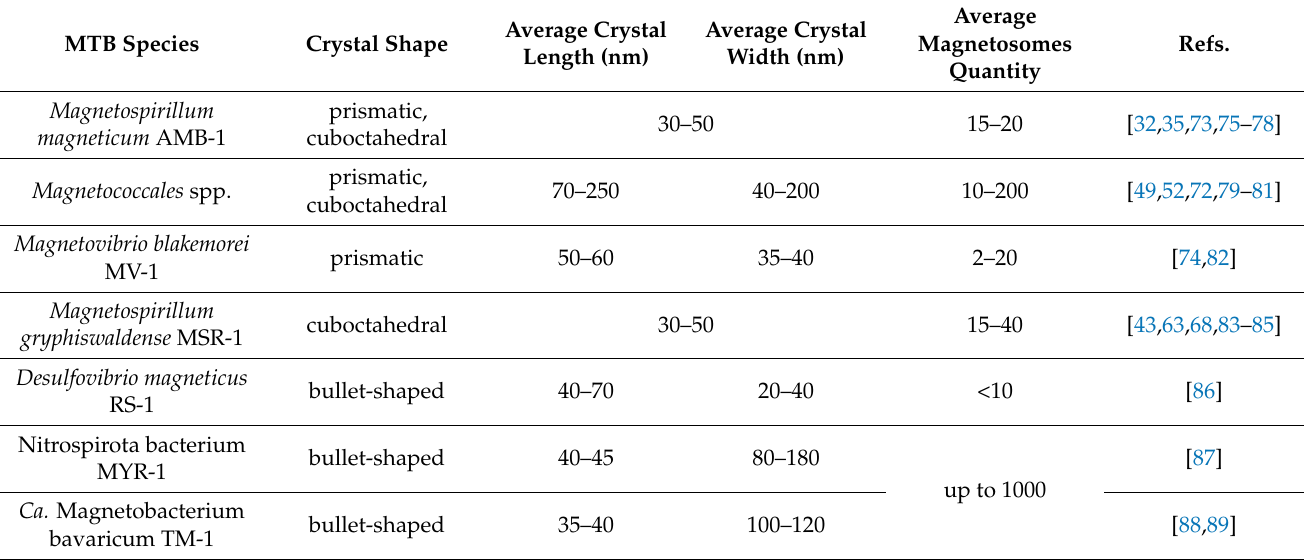
Table 1. Shape, size, and quantity of magnetosomes isolated from magnetotactic bacteria (MTB) of some species